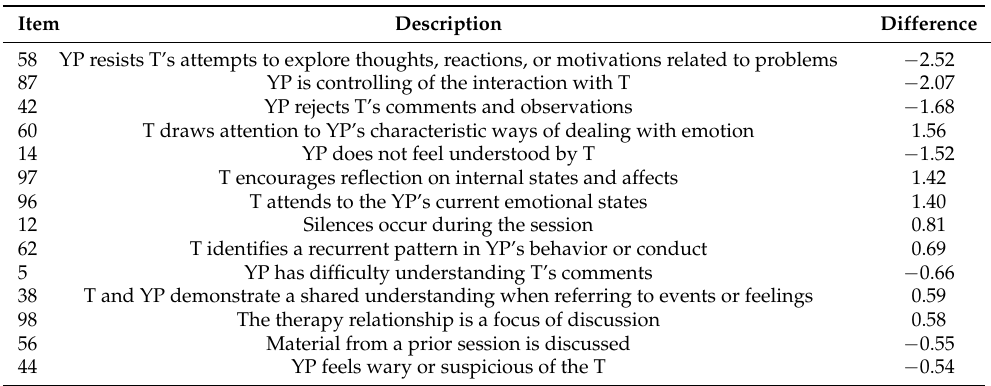
tion between the young person (YP) and therapist